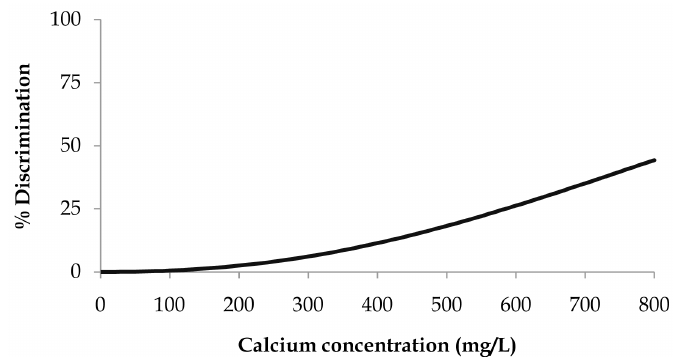
Figure 1. Calcium gluconate monohydrate threshold taste. Percent discrimination versus calcium concentration for the Weibull distribution.